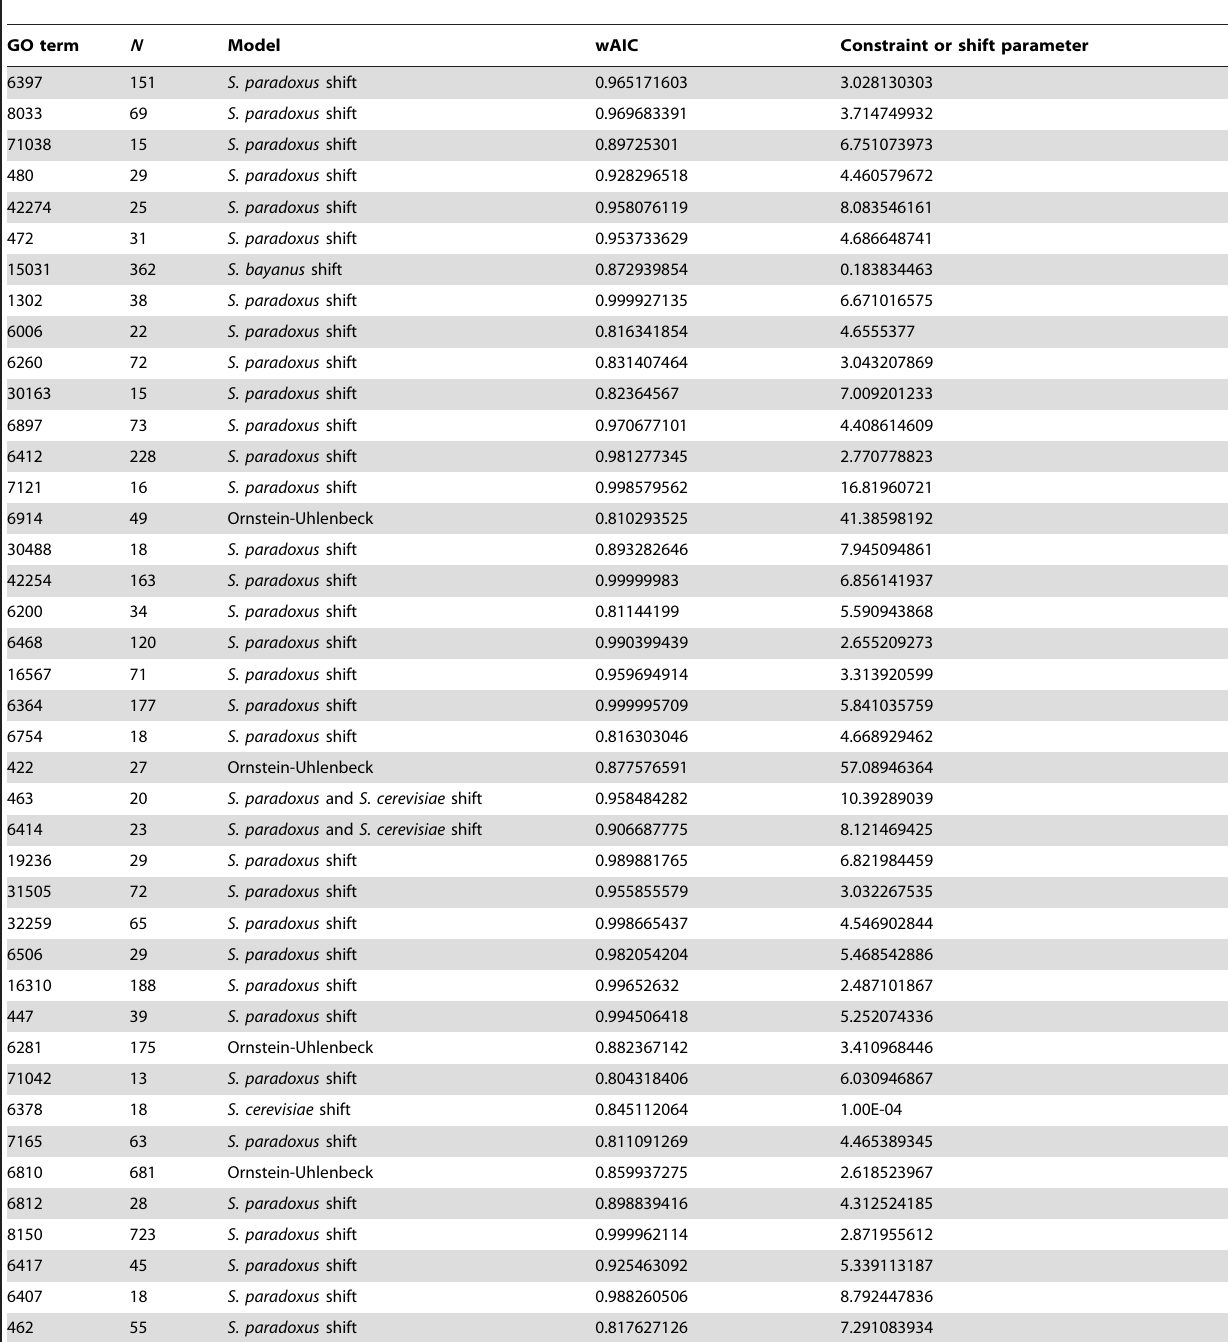
Table 2. Top-scoring fitted models of species regulatory evolution in yeast pathways from experimental expression